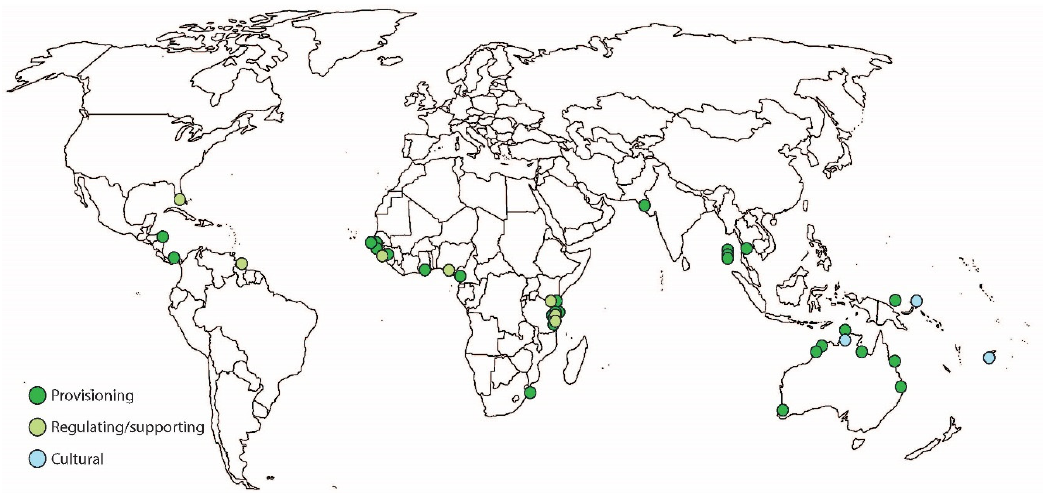
Figure 2. Approximate geographical distribution of historical reports of mangrove ecosystem services.